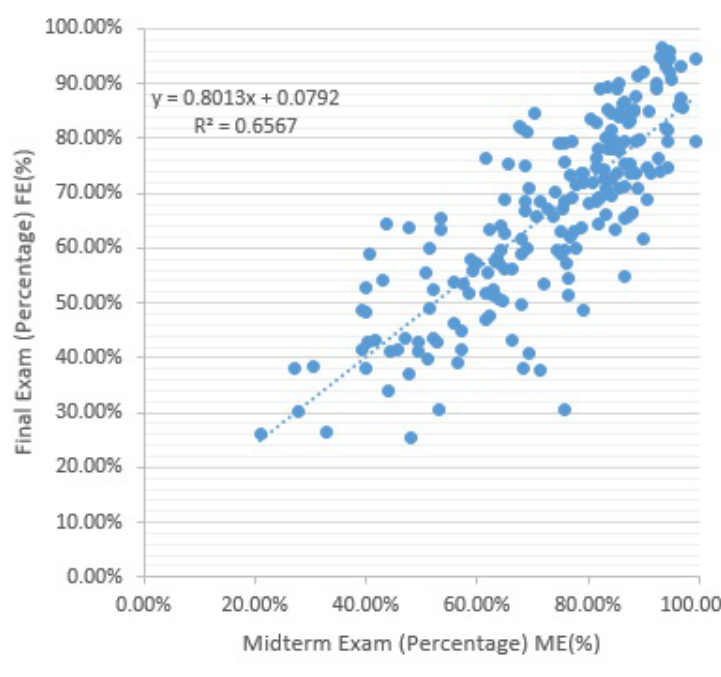
Figure 4 . Scattergram showing the correlation between ME and FE for N=200. As Figure 4 indicates, there is a strong, positive correlation (r = 0.81) between the live Midterm Exam test score (ME) and the live Final Exam test score (FE). The independent variable ME explains 65.67% of the variability in the FE variable (Table A2).